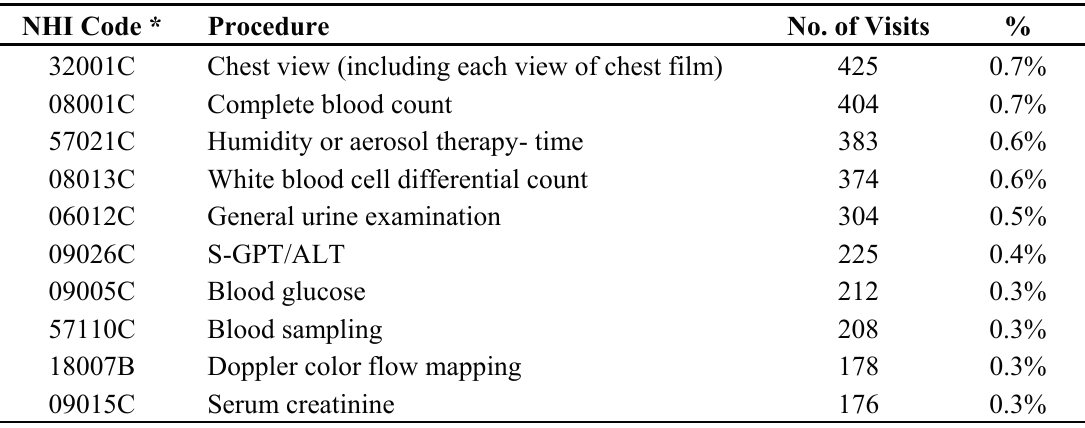
Table 4. Top ten procedures and laboratory tests prescribed by pediatricians, data from Taiwan’s National Health Insurance in 2012 (sampling rate: 1/500